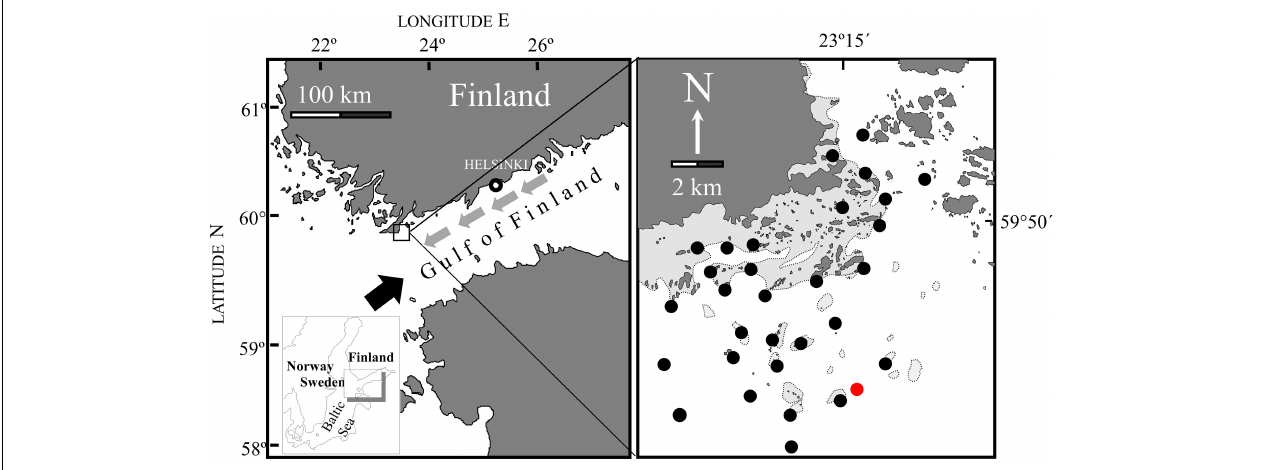
FIGURE 1 | Study area with sampling stations. Red dot shows the position of the water monitoring station Längden. Black arrow in the left panel shows the average wind direction, whereas smaller + gray arrows indicate the direction of the average sea currents. Flanked by stations with the coordinates (WGS84) N: 59.864005445 ◦ /23.264735324 ◦ , S: 59.757547032 ◦ /23.218394607 ◦ , W: 59.791964318 ◦ /23.137171110 ◦ , and E: 59.847815912 ◦ /23.303082314 ◦